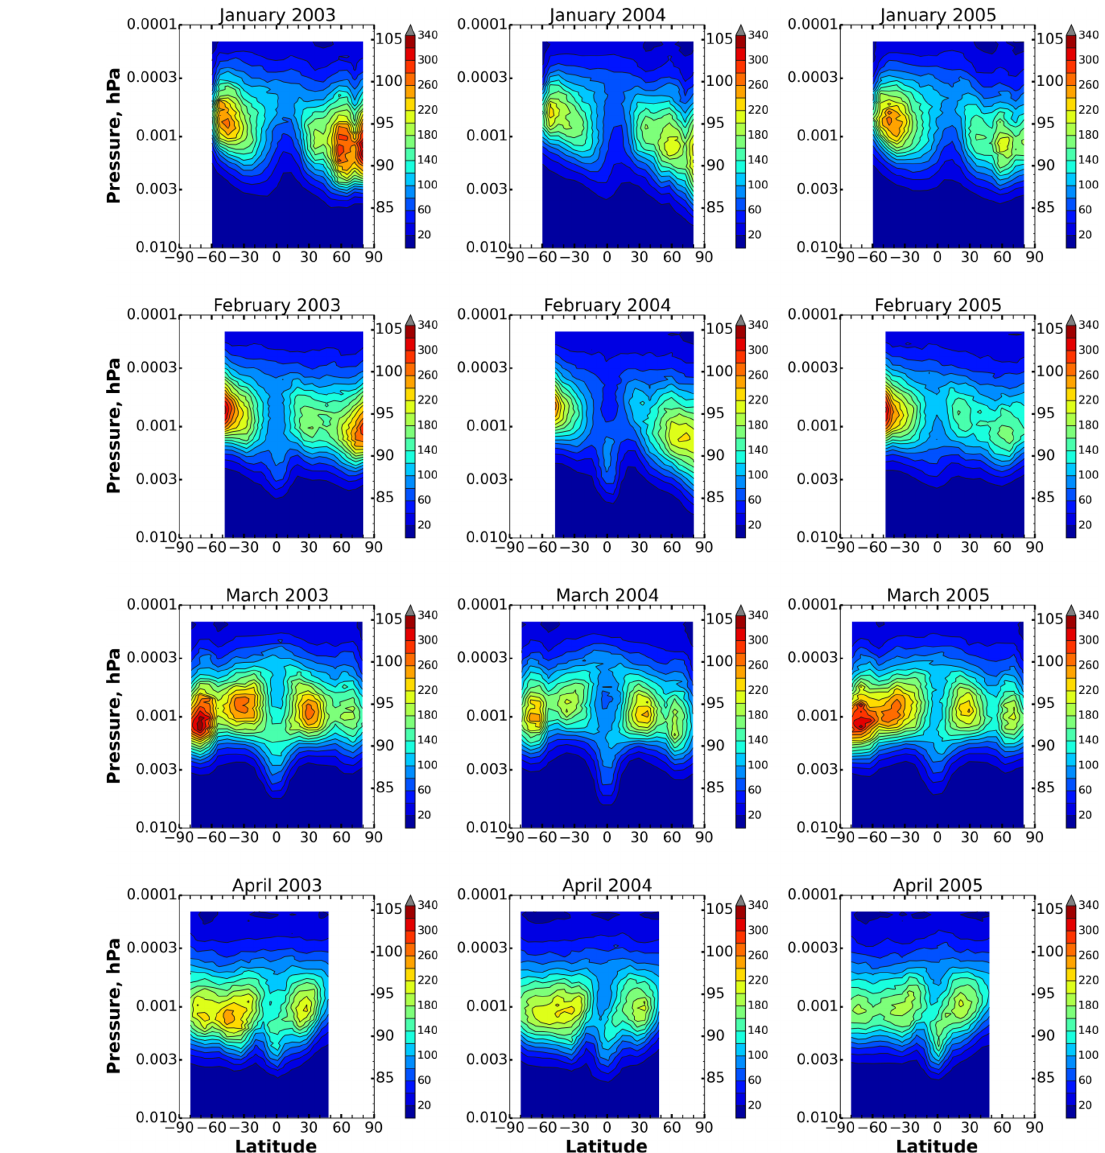
Figure 1. Monthly averaged O( 1 D) concentration (in cm − 3 ) in January–April of 2003–2005.